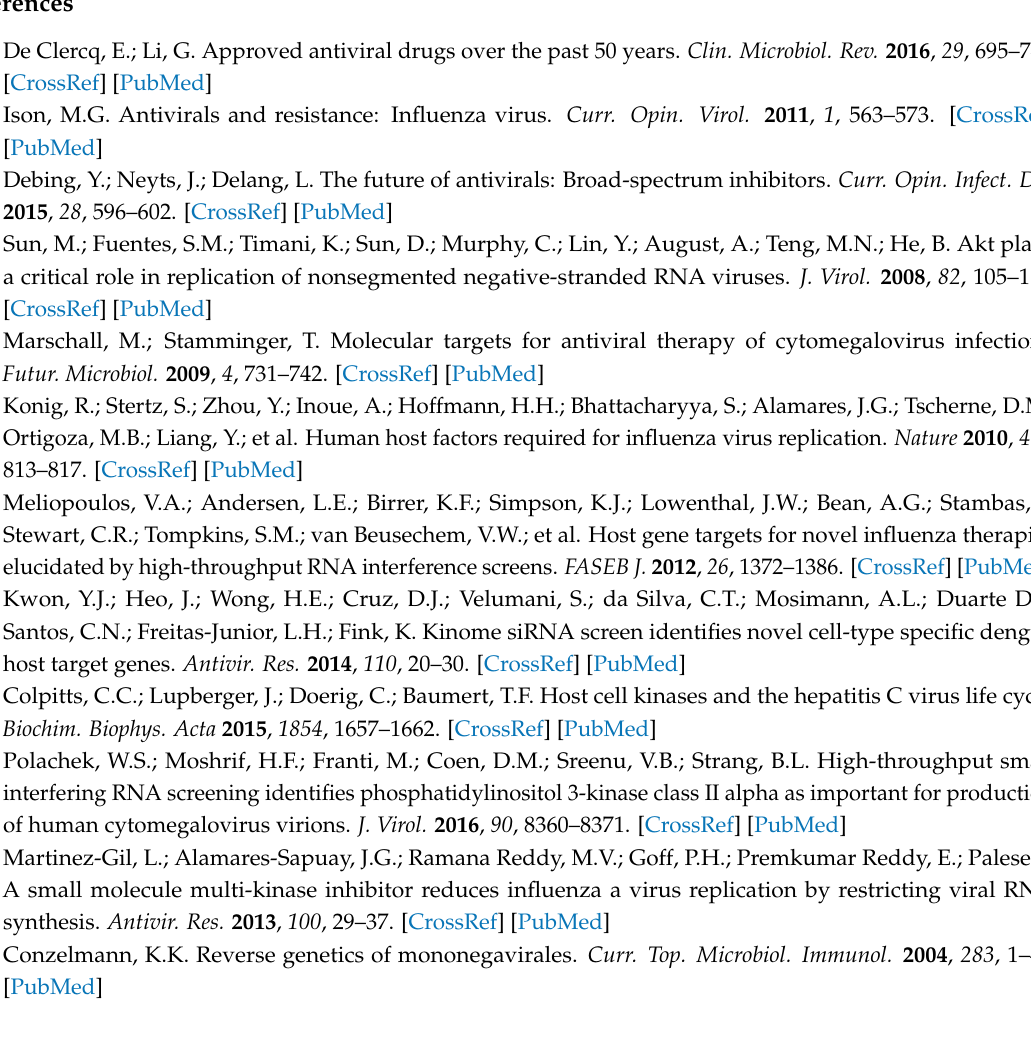
Table S1. List of kinase inhibitors that have been screened for antiviral activity against VSV* ∆ G(FLuc). Figure S1. Inhibition of VSV entry by lysosomotropic compounds. Figure S2. Effect of chloroquine on BHK-21 cell viability. Author Contributions: This work was performed by S.M. in partial fulfillment of the requirements for the PhD degree from the University of Bern (Graduate School for Cellular and Biomedical Sciences). S.M. and G.Z. conceived and designed the experiments; S.M. and S.L. performed the experiments; S.M. and G.Z. analyzed the data; and S.M. and G.Z. wrote the